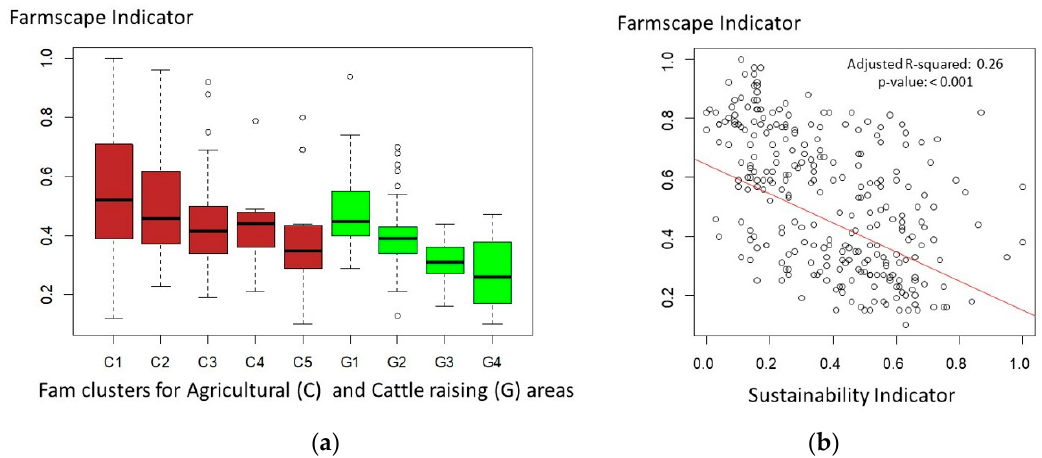
Figure 9. Variations of the farmscape indicator according to farm clusters ( a ) and correlation of the farmscape indicator with the sustainability index ( b ).